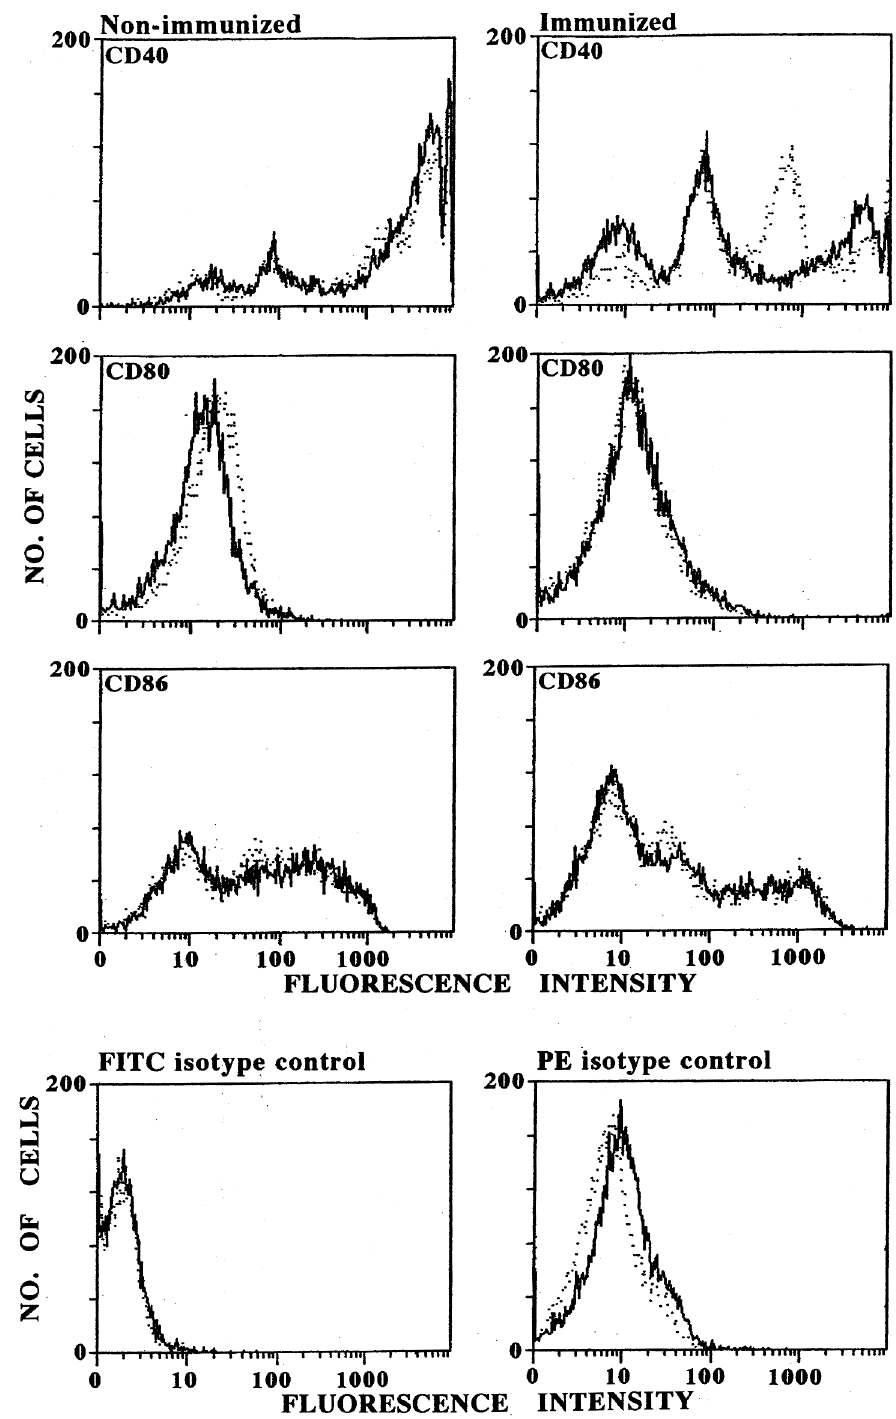
FIG. 1. Influence of roxithromycin on expression of co-stimulatory molecules on spleen cells prepared from BALB/c mice. Determination was done 24h after treatment. The data were analysed by overlay histograms (FL–1 or FL–2) of splenocyte population gated on lymphocyte position in scattered dots (FSC and SSC). The figure shows a representative expression profile of results obtained in four different experiments. [····], saline-treated control mice; [__], RXM-treated mice.